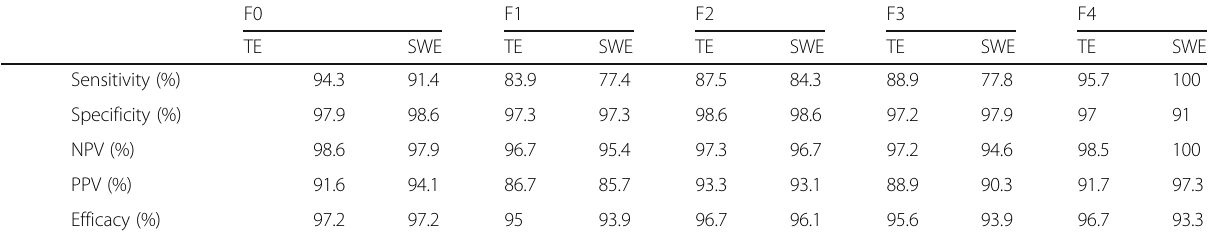
Table 4 The diagnostic validity of fibroscan (TE) and SWE compared to tissue biopsy at different fibrosis scores